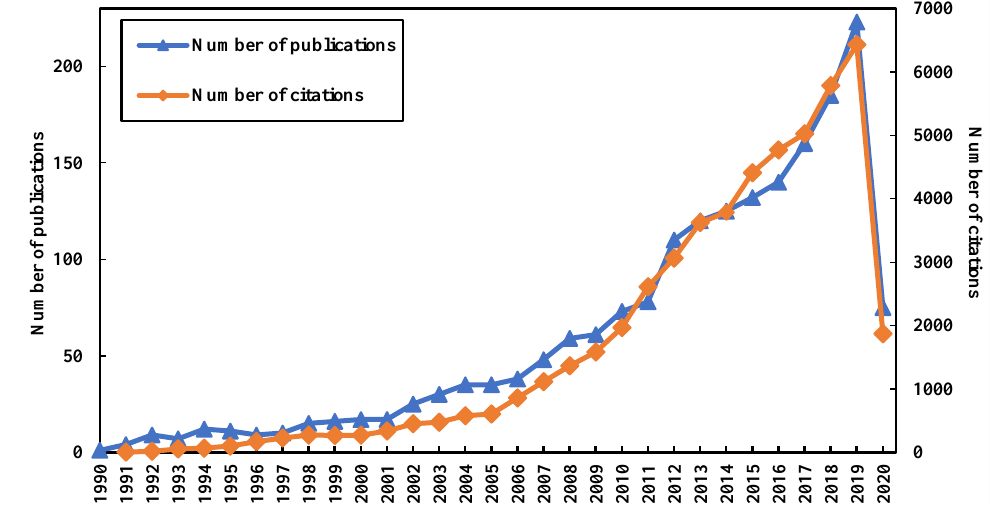
Figure 1. Number of publications and citations in the field of prediction of infectious diseases.